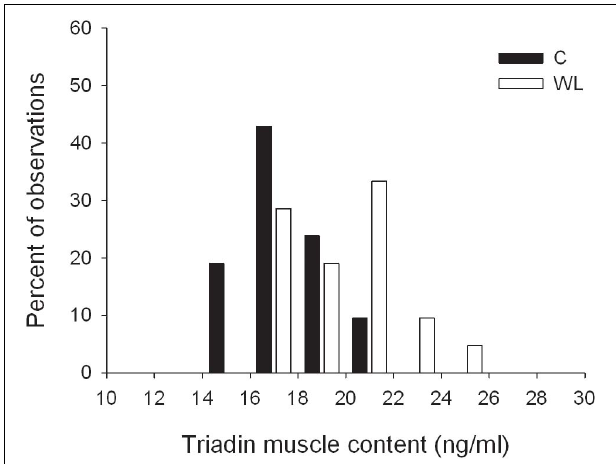
FIGURE 5 | Distribution of triadin muscle concentrations in trained and untrained